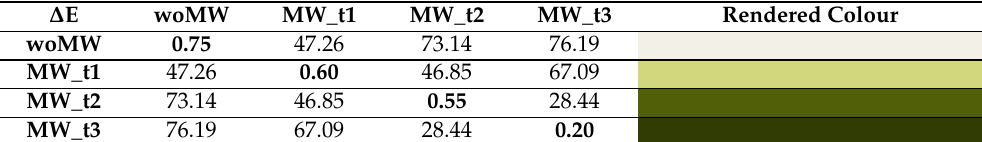
Table 6. Mean results of colour differences, ∆ E in CIE L*, a*, b* coordinates, between all the samples. Rendered colours are generated with RGB